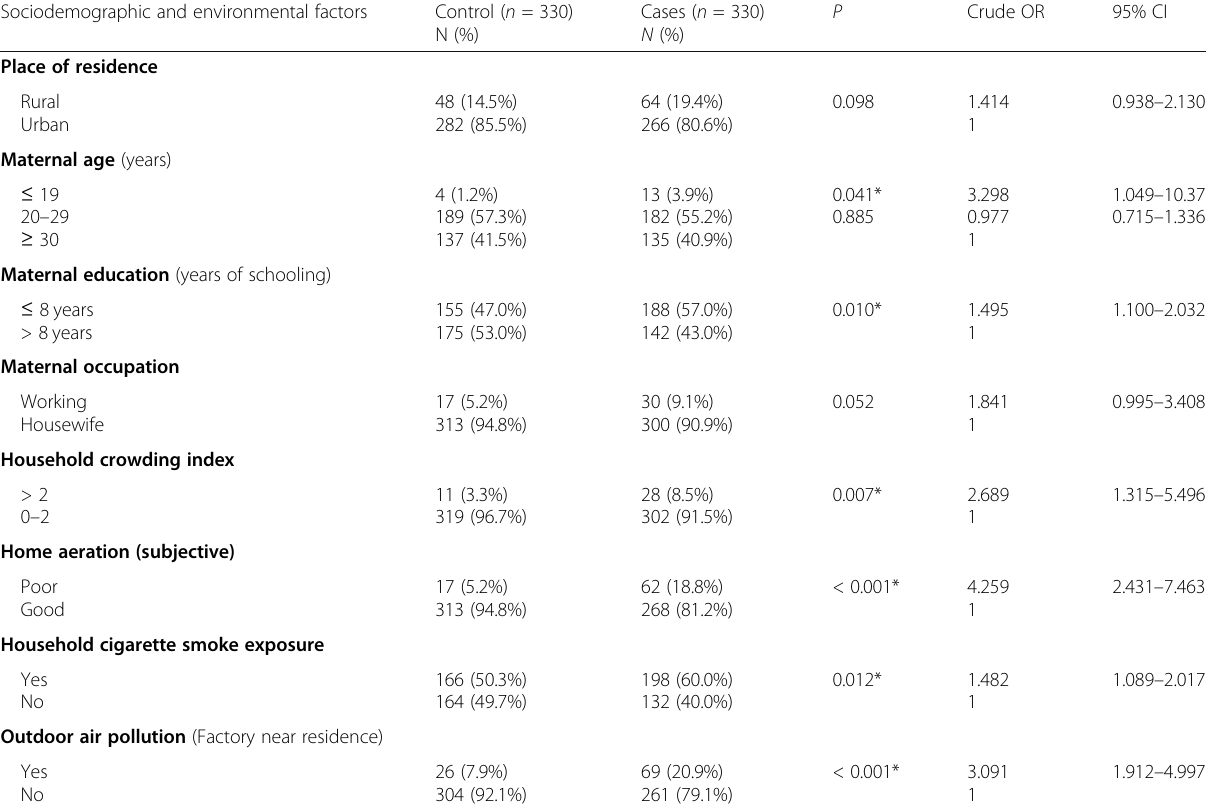
Table 2 Sociodemographic and environmental factors associated with the risk of pneumonia among under-five children Sociodemographic and environmental factors